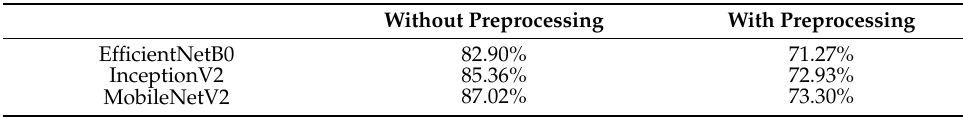
Table 7. Test accuracy results obtained on RoCoLe